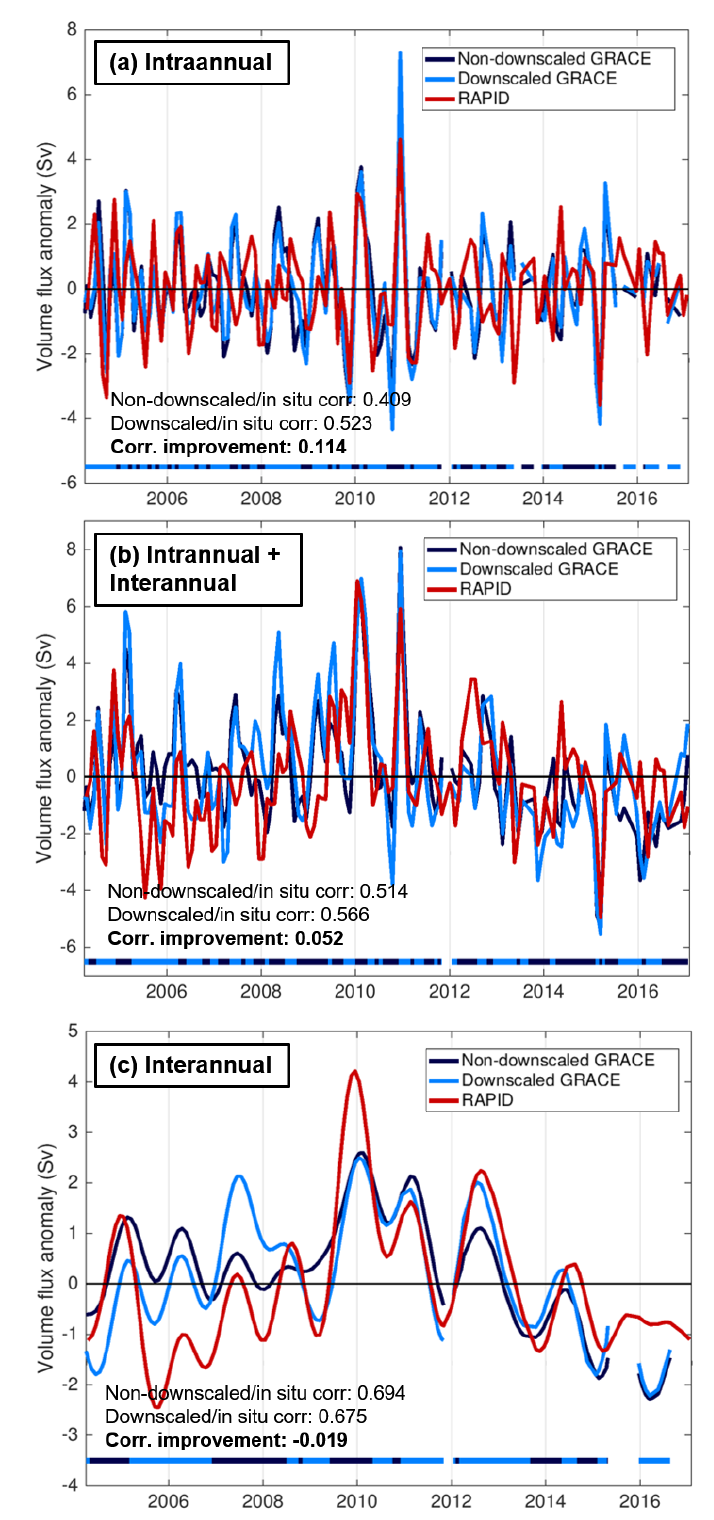
Figure 10. Comparison of volume flux (transport) anomaly time series in the Atlantic across 26.5 ◦ N, at 3000–5000 m depth. Horizontal bars at the bottom indicate which GRACE OBP value was closer to the RAPID value at that time, similarly to Figure 6. The time series are filtered for ( a ) 3–12 month timescales, ( b ) timescales > 3 months, and ( c ) timescales > 14 months; all time series have temporal mean, trend, and seasonal cycle